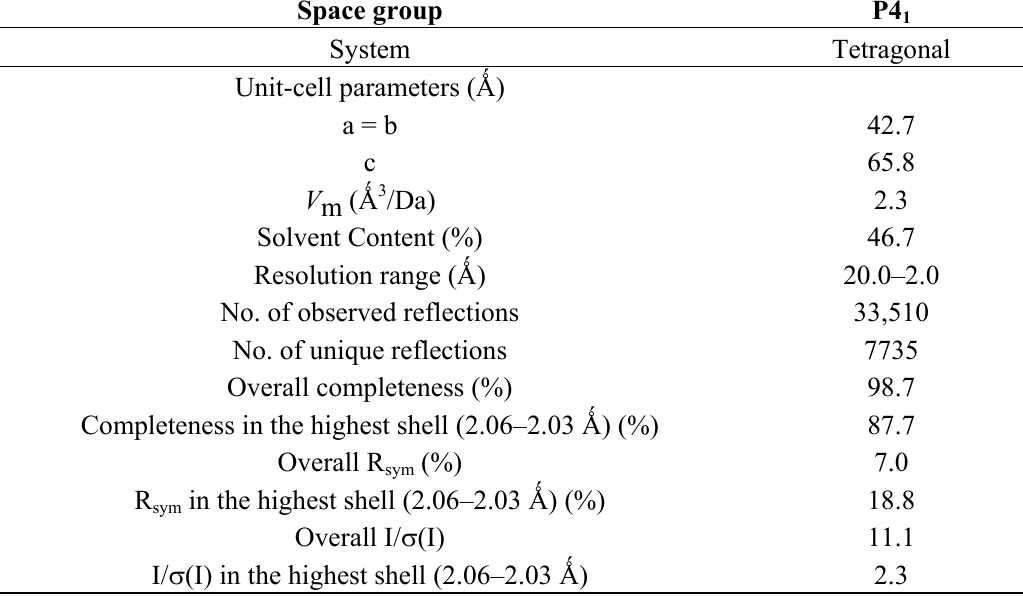
Table 1. Data collection